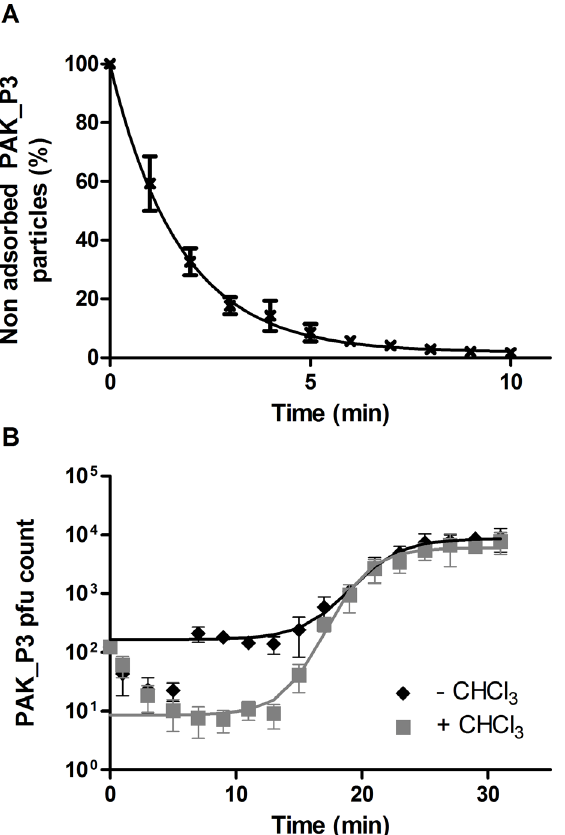
Fig 1. PAK_P3 rapidly adsorbs to its host and efficiently produces new progenies. (A) Adsorption assays of PAK_P3 on P . aeruginosa strain PAK. (B) One-step growth curve of PAK_P3. Samples treated with (grey squares) or without (black diamonds) CHCl 3 . A logistic regression was used to fit the data. Four independent experiments were combined and data are presented as means with standard deviations.